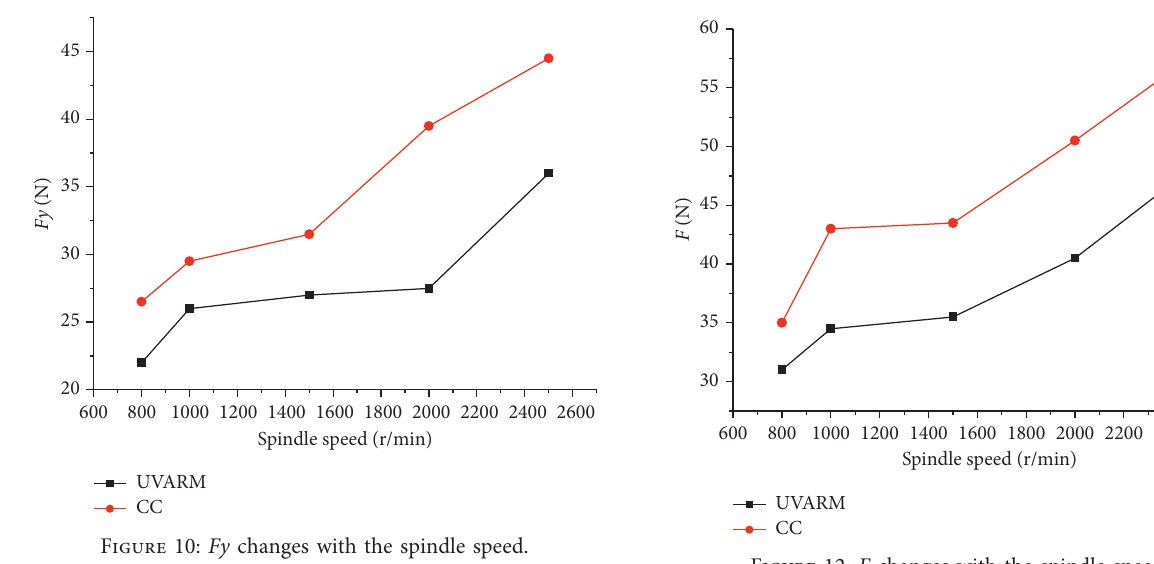
Figure 10: Fy changes with the spindle speed.